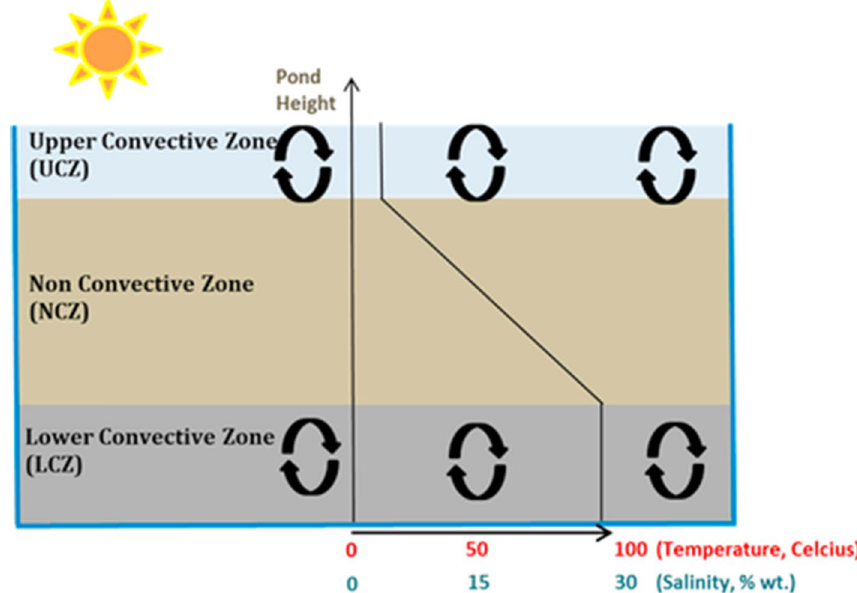
Fig. 28 Solar pond construction which contained different zones (Ding et al.